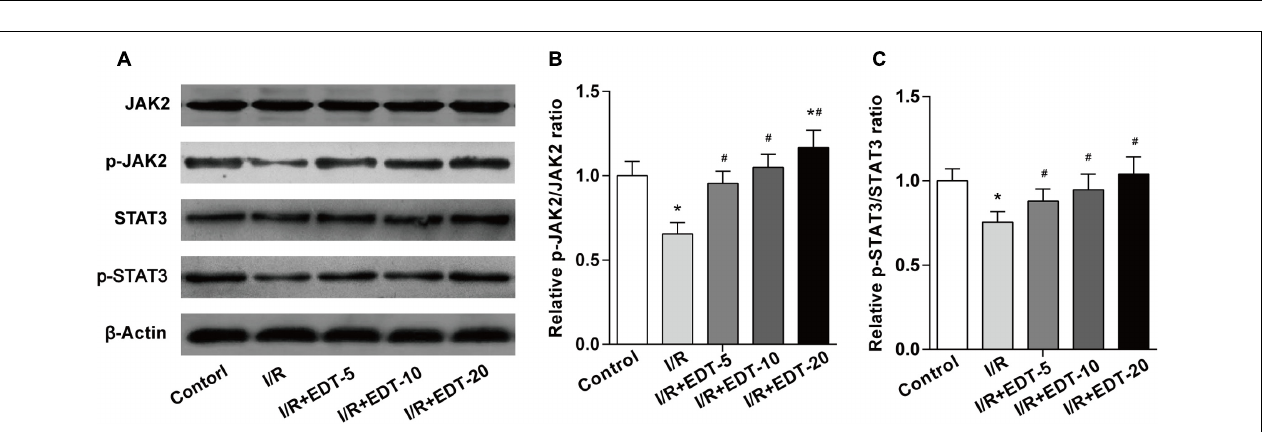
FIGURE 3 | Eriodictyol treatment inhibits the cardiomyocyte apoptosis induced by I/R injury. (A) The cardiomyocyte apoptosis was examined by TUNEL assay. Brown staining of the nucleus indicates cell apoptosis. Scale bar: 20 µ m. (B) The protein levels of Bax, Bcl-2 and cleaved Caspase-3 in cardiac tissues were measured by western blot. (C) Statistical analysis of Bax, Bcl-2 and cleaved Caspase-3 protein levels in cardiac tissues. n = 4 per group. The protein ratios were normalized to the values of the control group. All data are the mean ± SD. ∗ P < 0.05 compared with control group, # P < 0.05 compared with I/R group.